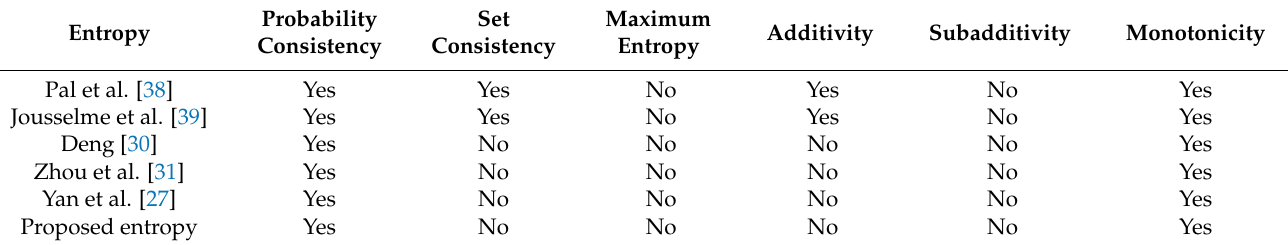
Table 1. The properties of different